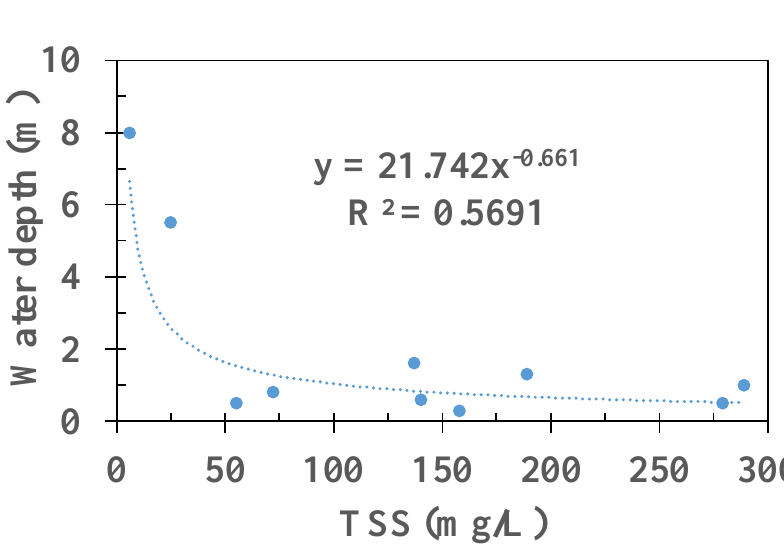
Figure 5. Relationship of TSS with water depth (data source Table 5).